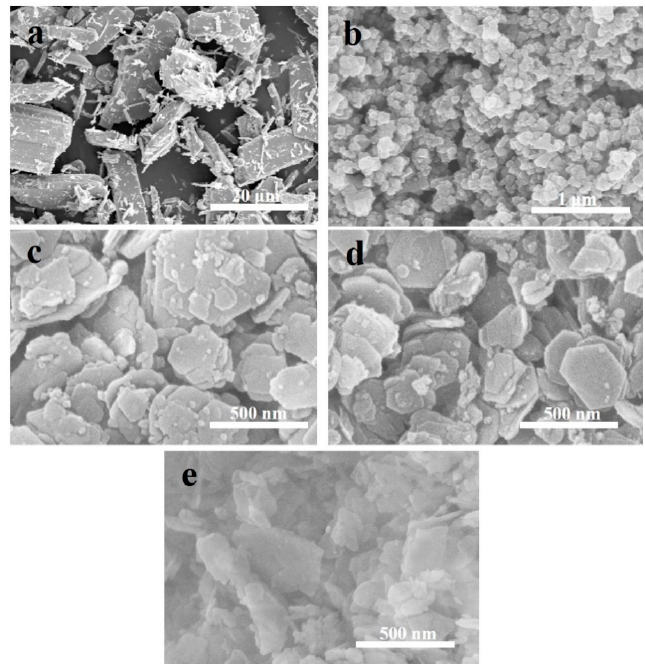
Figure 5. SEM images of ( a ) commercial MoO 3 , ( b ) MoO 3 (N), ( c ) HMCM-49, ( d ) 6Mo(N)-HMCM-49, and ( e ) 6Mo(C)-HMCM-49. and ( e )